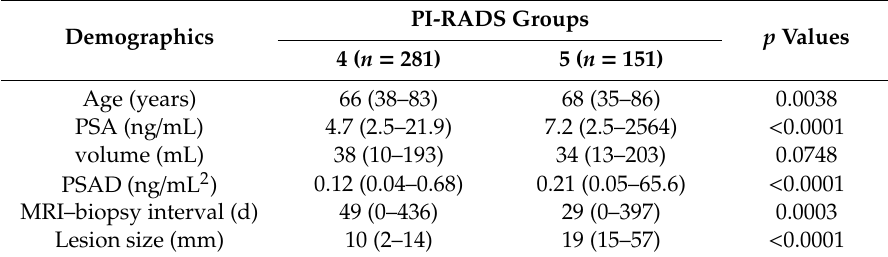
Table 1. Patient